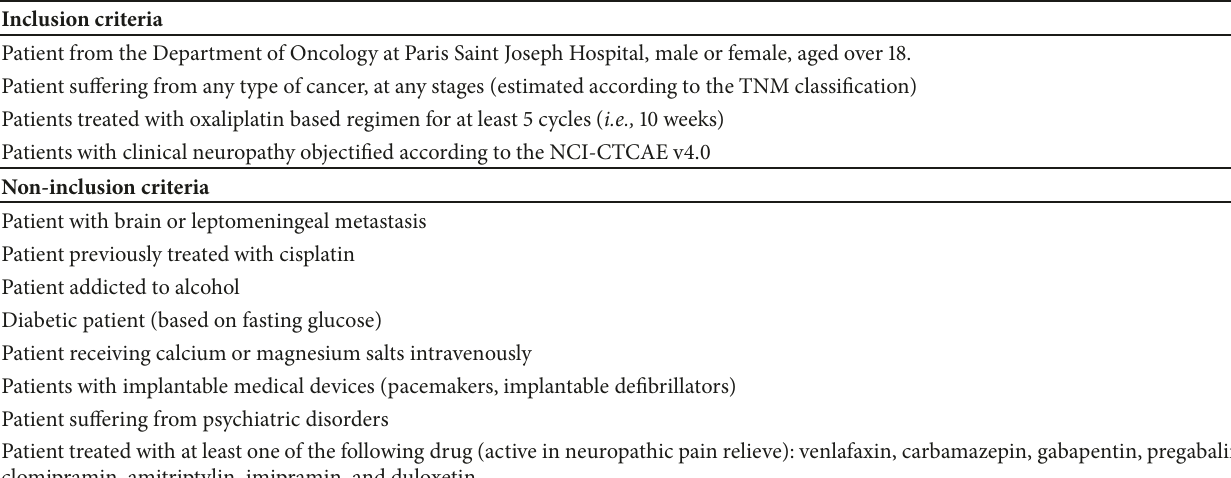
Table 1: Eligibility criteria of Canaloxa